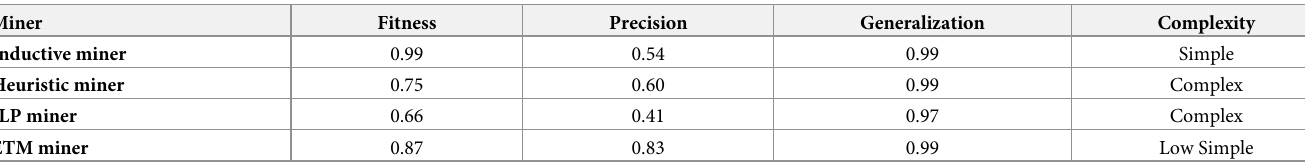
Table 7. Comparison among the four applied